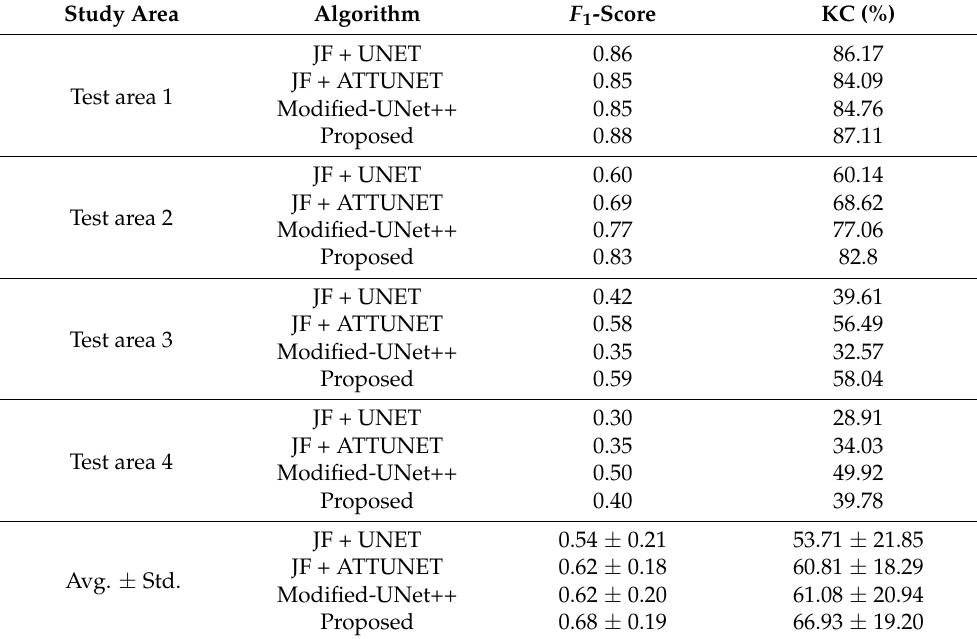
Table 4. F 1 -score and KC with data-augmented training pair images for the KOMPSAT-3